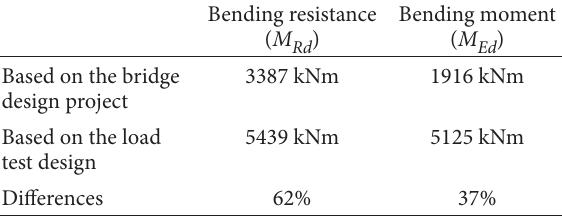
Fig. 4. Full load (1961 kN) placed on the bridge, image view from the scanners position from the Southern side of the Table 1. Bending moments and resistance’s